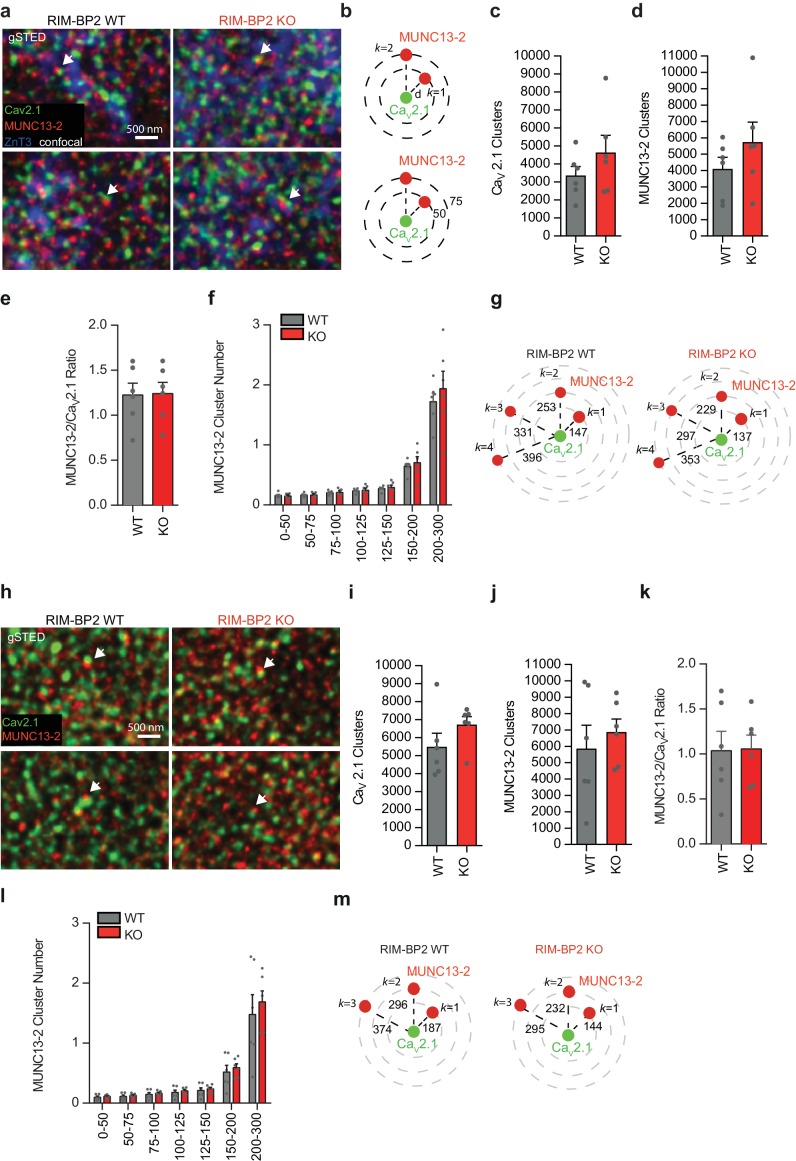
Loss of RIM-BP2 does not alter Munc13-2 levels at both MF-CA3 and CA3-CA1 synapses.(a) Representative gSTED images of Cav2.1 and Munc13-2 clusters at MF boutons (MFB) identified by ZnT3 expression (confocal) in RIM-BP2 WT and KO brain sections. Arrows indicate Munc13-2 clusters nearby Cav2.1 clusters. (b) Example of k nearest neighbor distance analysis of Munc13-2 clusters relative to a given Cav2.1 cluster at MF synapses. Following image thresholding and Watershed segmentation, X and Y coordinates of each segmented cluster identified were retrieved and Euclidean distances of for example Munc13-2 clusters relative to a given Cav2.1 cluster calculated with a custom-written MATLAB script (b, upper). Similarly, we retrieved the number of for example Munc13-2 clusters found at specific distance intervals (nm) from a given Cav2.1 cluster (b, lower). Several hundreds to thousands of clusters per image were analyzed and values averaged per animal. (c) Average number of Cav2.1 clusters within the ZnT3 +area found per each RIM-BP2 WT (n = 6) and KO (n = 6) animal analyzed. ZnT3 was used as marker to identify MF synapses. (d) Average number of Munc13-2 clusters within the ZnT3 +area found per each RIM-BP2 WT and KO animal analyzed (e) Ratio of Munc13-2- clusters/Cav2.1 clusters in RIM-BP2 KO and WT mice. (f) Number of Munc13-2 clusters at determined distance intervals (nm) from a given Cav2.1 cluster and distance at which the closest k neighbor (k = 1,2,3,4; g) is found. No significant difference was observed between RIM-BP2 KO and WT mice. (h) Representative gSTED images of Cav2.1 and Munc13-2 clusters at CA3-CA1 synapses in RIM-BP2 WT and KO brain sections. Arrows indicate Munc13-2 clusters nearby Cav2.1 clusters. (i) Number of Cav2.1 clusters and Munc13-2 clusters (j) found at CA3-CA1 synapses in RIM-BP2 KO (n = 6) and WT mice (n = 6). (k) Ratio of Munc13-2 clusters/Cav2.1 clusters at CA3-CA1 synapses. (l) At CA3-CA1 synapses, loss of RIM-BP2 does not significantly alter either the number of Munc13-2 clusters at determined distance intervals (nm) from a given Cav2.1 cluster or the distance at which the closest k neighbor (k = 1,2,3) is found (m). Values represent mean ± SEM. For statistics please see Figure 3—figure supplement 4—source data 1.10.7554/eLife.43243.016Figure 3—figure supplement 4—source data 1.Statistics of data presented in Figure 3—figure supplement 4.